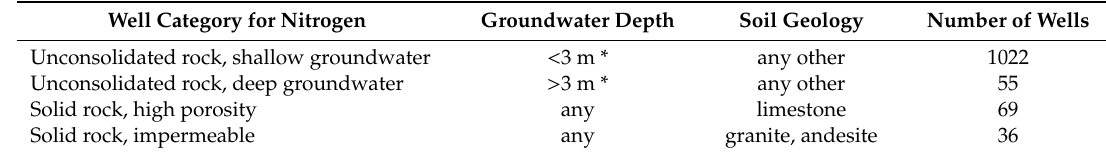
Figure 3. Shallow groundwater wells used for model calibration and geological and soil types according to MONERIS classification (GW – Groundwater, DIN – dissolved inorganic nitrogen). Table 1. Well categories for nitrogen.